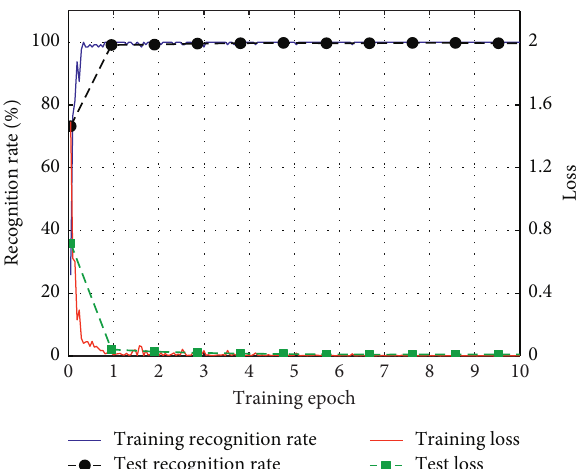
Figure 15: Training and verification process of fault diagnosis network.